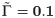
Density and current profiles numerically computed via stochastic simulations (blue and magenta dots, respectively) and analytically estimated (black lines) for Γ˜=0.1 and L = 1: (a, b) LD: α˜ = 0.2, β˜ = 1; (c, d) HD: α˜ = 1, β˜ = 0.2; (e, f) MC: α˜ = 1, β˜ = 1.Hopping and drop-off events are scheduled based on the Gillespie algorithm [41]. All simulations, here and in the following, are for 107 iteration steps (each iteration corresponds to one reaction: initiation, elongation, drop-off or termination). The first 2 ⋅ 107 iterations were discarded to make sure that the system was in a steady state. Unless otherwise stated, a lattice size of 500 sites was used.